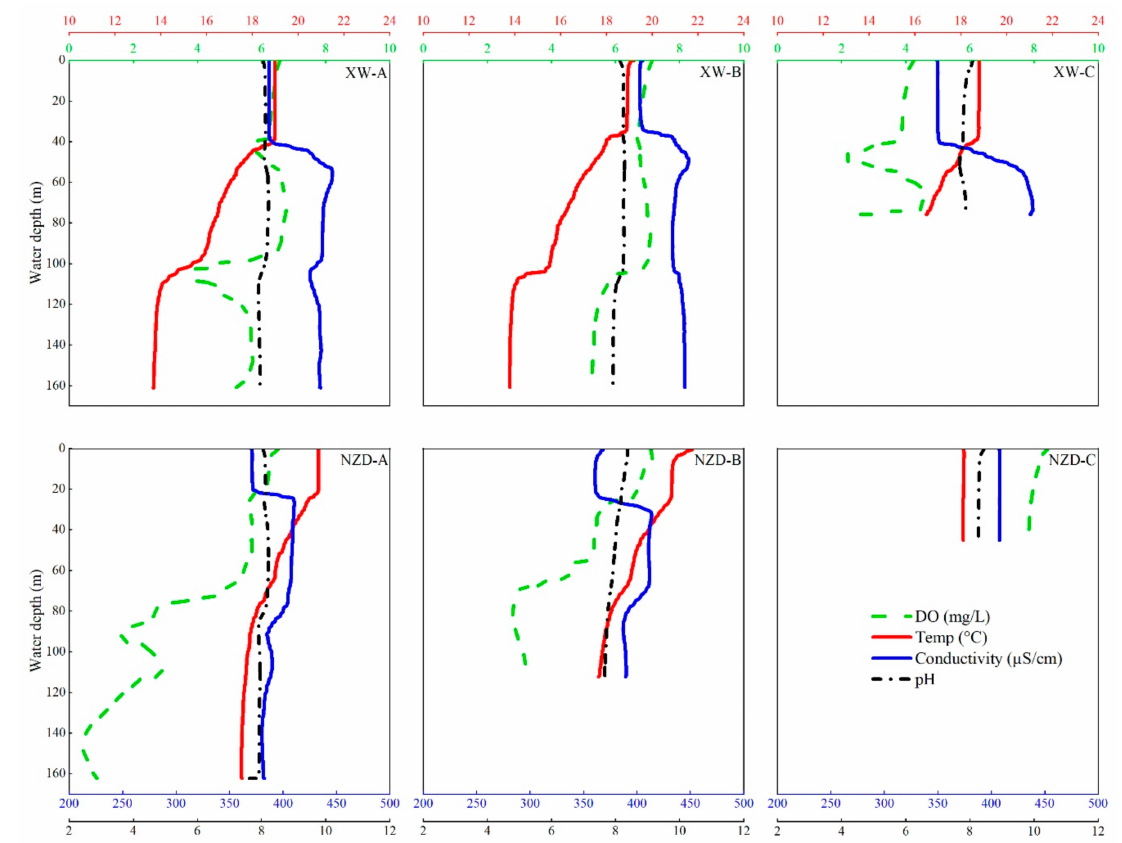
Figure A1. The vertical profiles of the physicochemical characteristics of the sampling